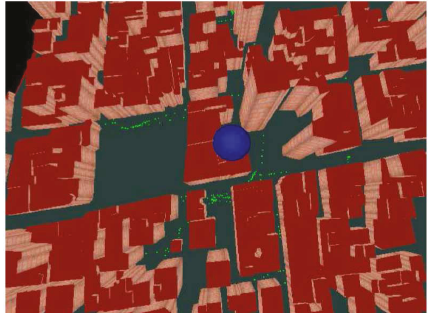
Figure 12: 3D urban model for Cali using a game engine.